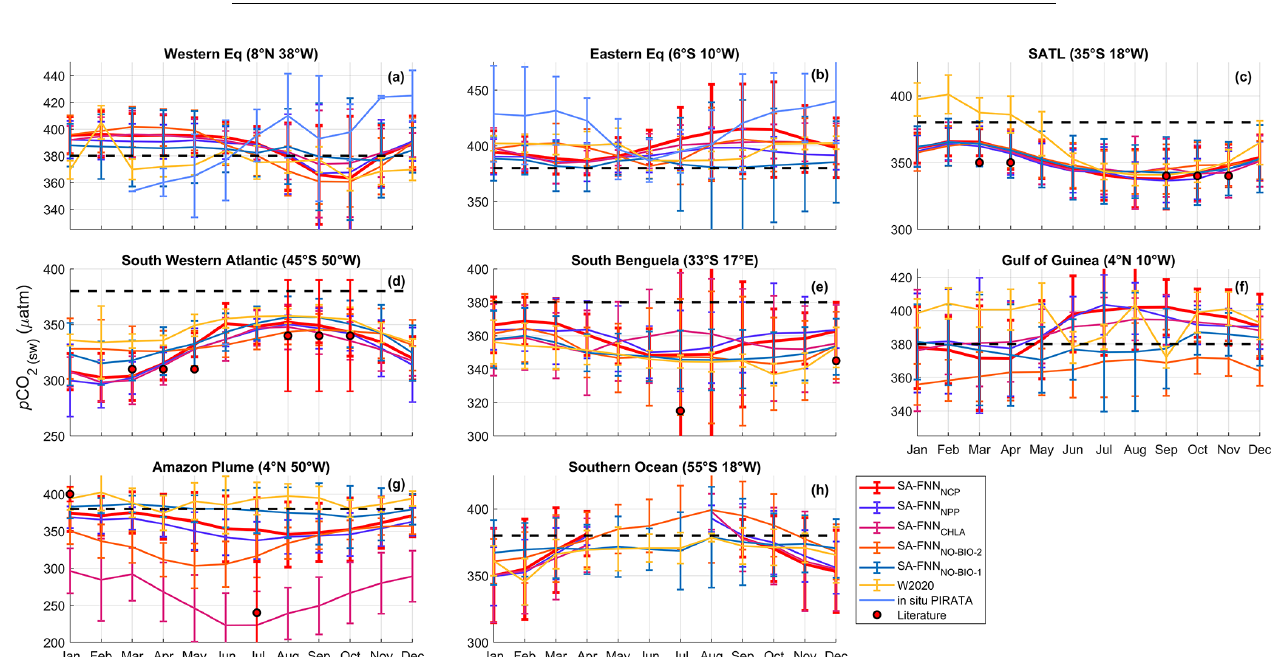
Figure 3. Monthly climatologies of p CO 2 ( sw ) referenced to the year 2010 for the eight stations marked in Fig. 1 from the SA-FNN NCP , SA-FNN NPP , SA-FNN CHLA , SA-FNN NO-BIO-1 , SA-FNN NO-BIO-2 and W2020 (Watson et al., 2020b). Light blue lines in Fig. 3a and b indicate the in situ p CO 2 ( sw ) observations from PIRATA buoys. The atmospheric CO 2 increase was set as 1.5µatmyr − 1 . Black dashed line indicates the atmospheric p CO 2 ( ∼ 380µatm). Error bars indicate the 2 standard deviations of the climatology ( ∼ 95% interval), where larger error bars indicate a larger interannual variability. Red circles indicate the literature values of p CO 2 ( sw ) described in Sect. 4.2. Note the different y -axis limits in each